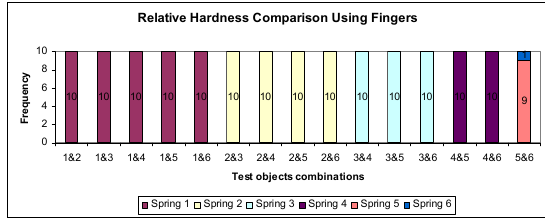
Fig. 7. Relative hardness comparison of the six test objects using thumb and index finger.